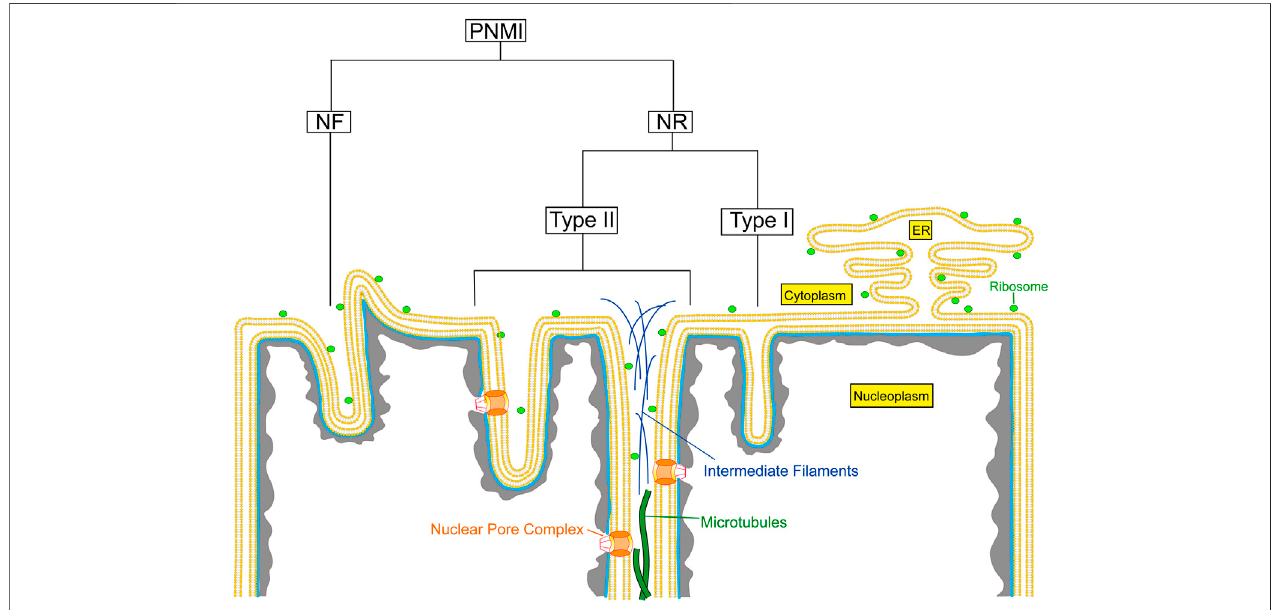
FIGURE 1 | Schematic overview of the different types of nuclear membrane invaginations. PNMI, Pleiomorphic nuclear membrane invaginations; NR, Nucleoplasmic reticulum; NF, Nuclear folds.